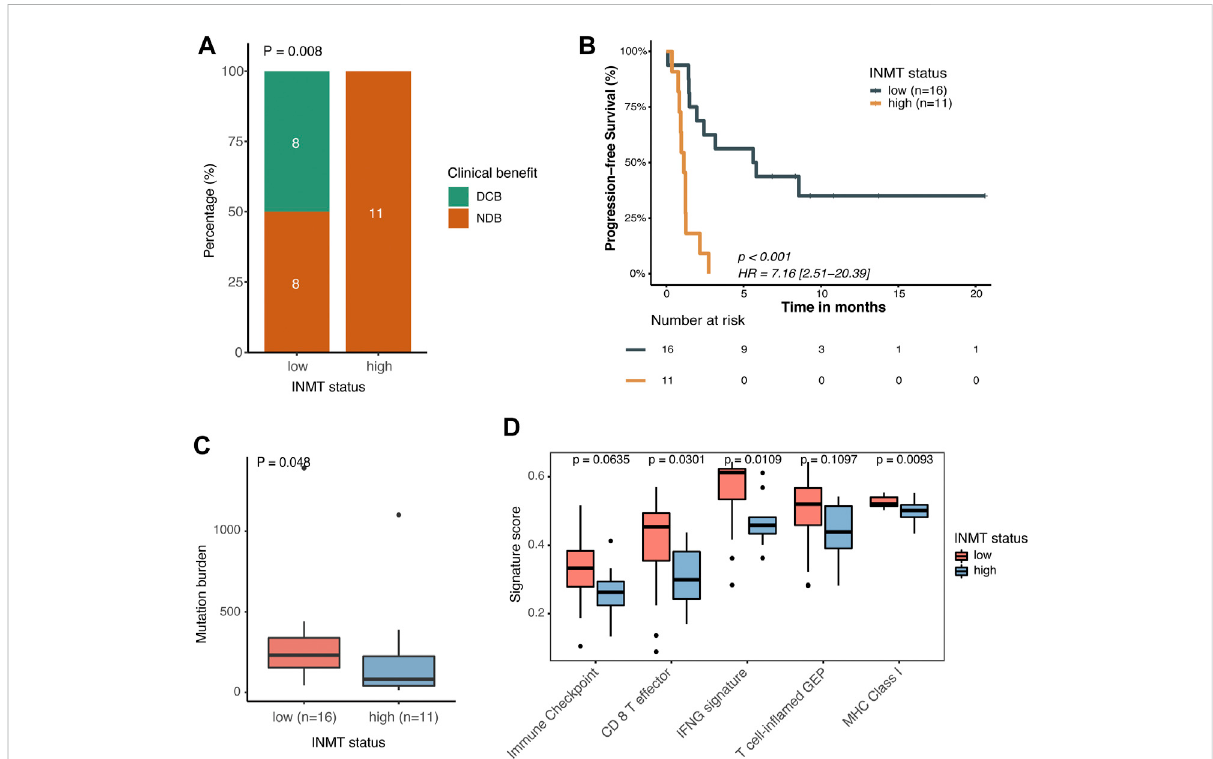
FIGURE 8 Association between INMT and immunotherapy response in a PD-1 immunotherapy cohort of NSCLC (GSE135222). (A) Clinical bene fi t rate among INMT low-and high-expression groups. Fisher ’ s exact test was used for the analysis. (B) Kaplan – Meier curve for progression-free survival according to an INMT expression status. The log-rank test was used for the analysis. (C) TMB distribution between INMT low- and high-expression groups. The Wilcoxon rank-sum test was used for the analysis. (D) Boxplot of enrichment scores of immune-related signatures among INMT low- and high-expression groups. The Wilcoxon rank-sum test was used for the analysis. DCB, durable clinical bene fi t; NDB, non-durable clinical bene fi t; HR, hazard ratio; TMB, tumor mutation